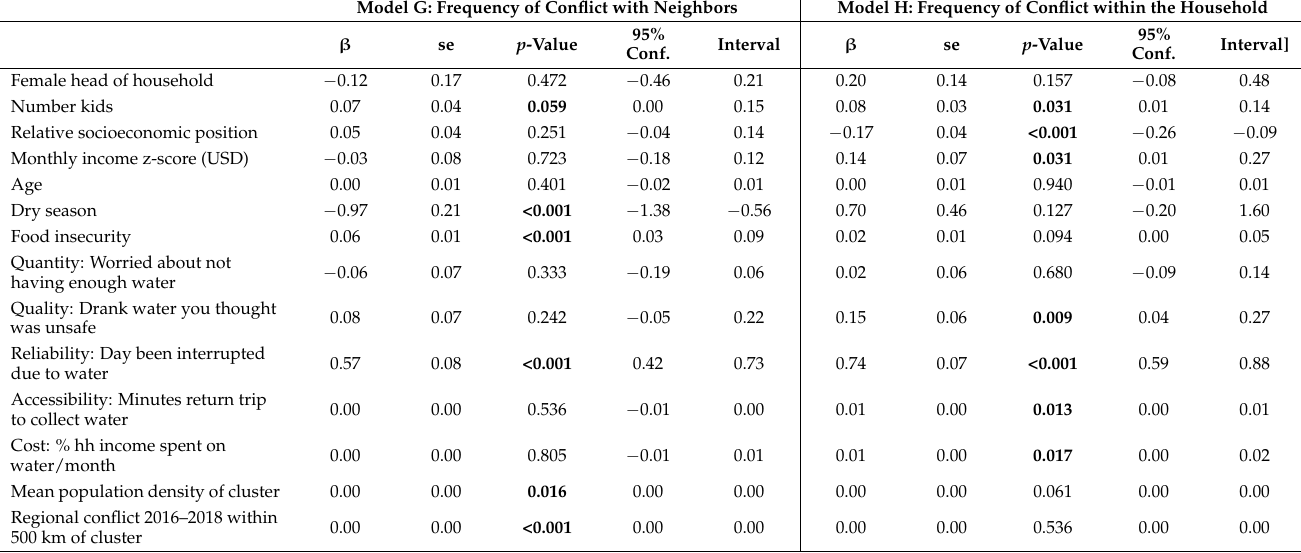
Table 7. Ordinal logistic regression modeling results for associations between demographic characteristics, water insecurity domains, regional conflict, population density, and conflict with neighbors (Model G) or within the household (Model H) in urban areas only.